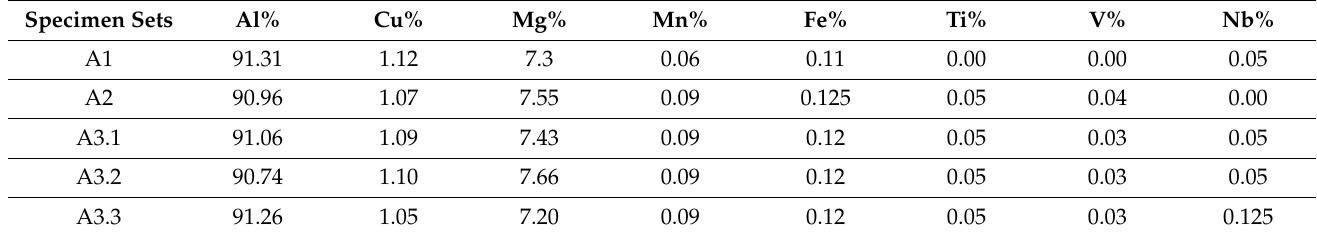
Table 5. Alloy Compositions A1 and